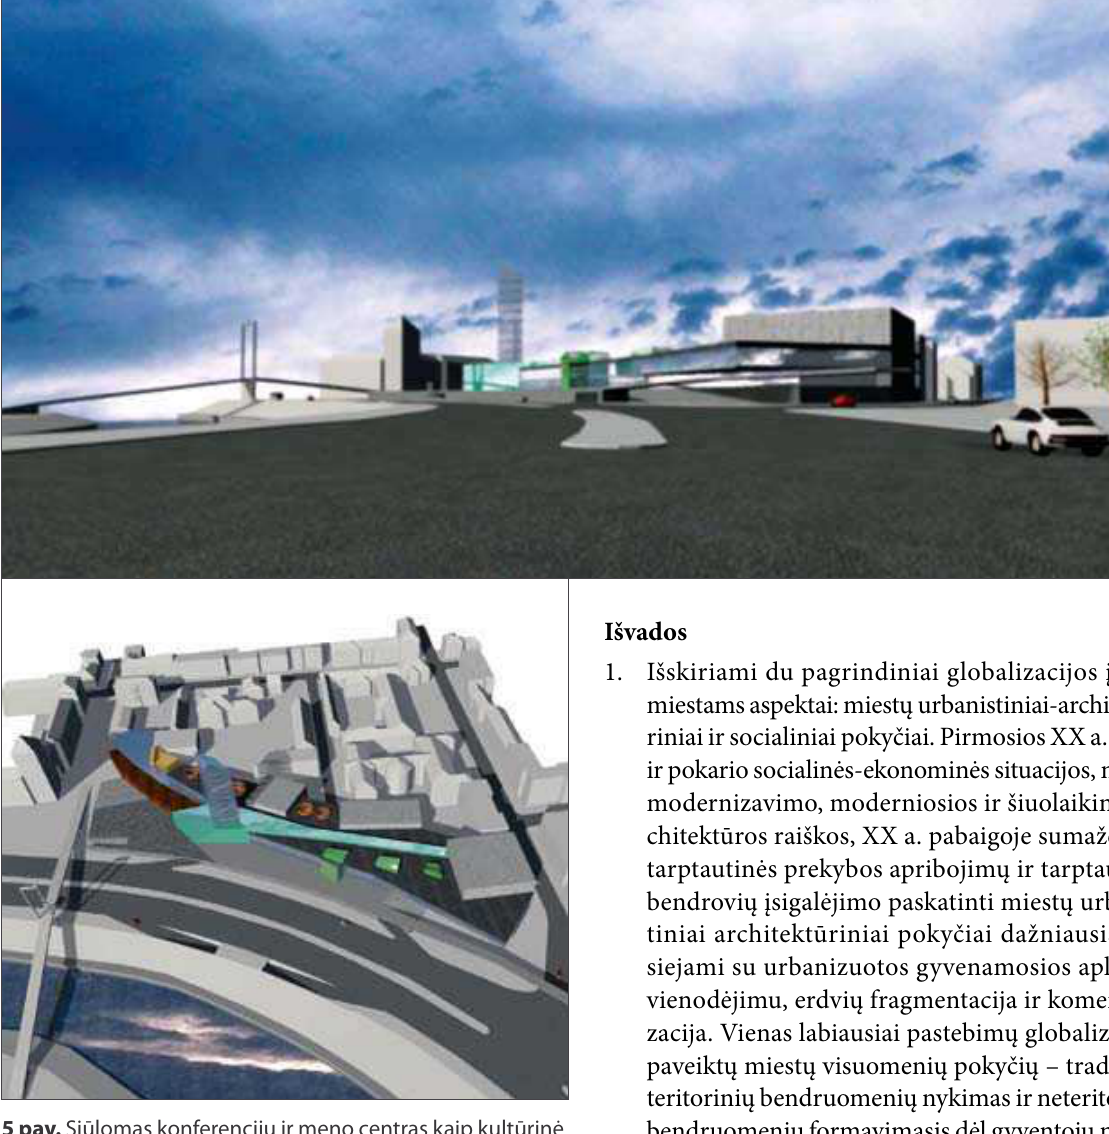
Fig. 5. Proposed Conference and Art Center as a cultural counterweight for Commercial and Entertainment Center “Akropolis” (by A. Gabrys